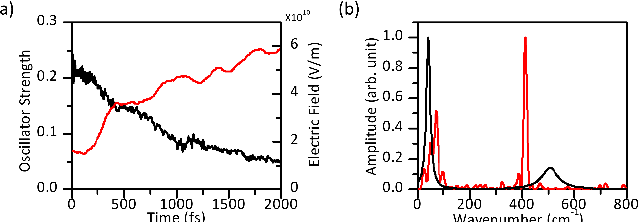
Fig. 2. QM/EFP-MD simulation results. (a) Averaged oscillator strength vs. time (black line) and averaged electric field at the centre of BA in the direction of the central C-C bond. (b) LPSVD result of the TF data of BA in acetonitrile detected at 420 nm (black line) and the Fourier transform of the residuals of the transition energy between the ground and the S 1 state (red